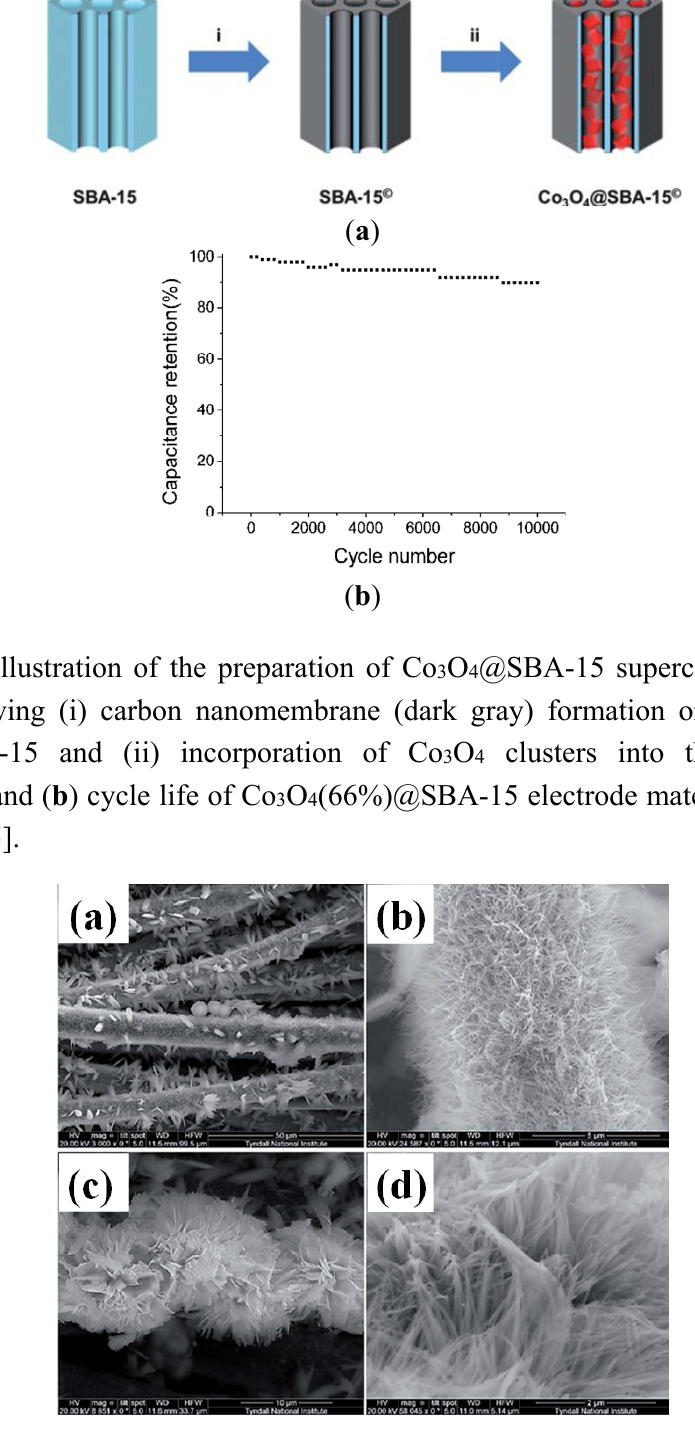
Figure 10. HRSEM images of Co 3 O 4 nanowire/nanoflower on carbon fibre cloth at different magnifications [66]. ( a ) and ( b ) are the low magnification SEM images of bundles of carbon fibers; ( c ) and ( d ) are the high magnification SEM